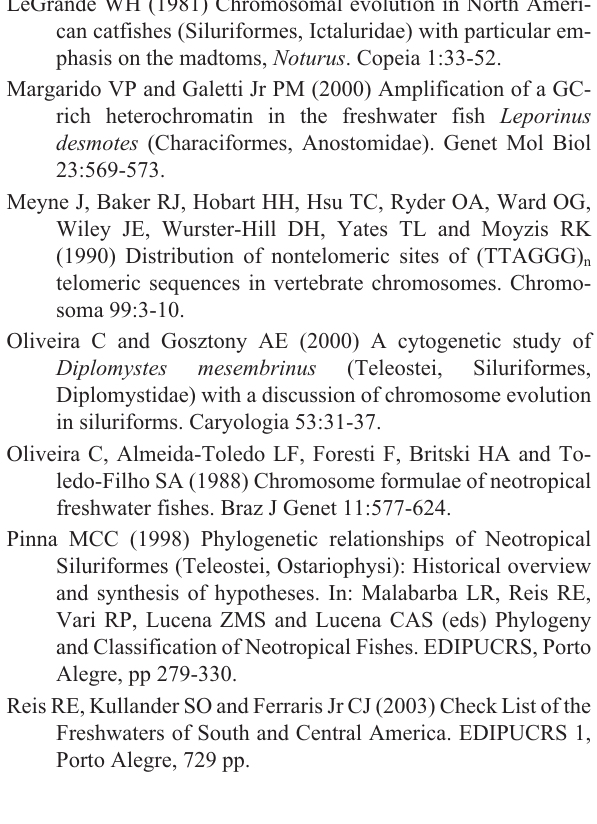
LeGrande WH (1981) Chromosomal evolution in North